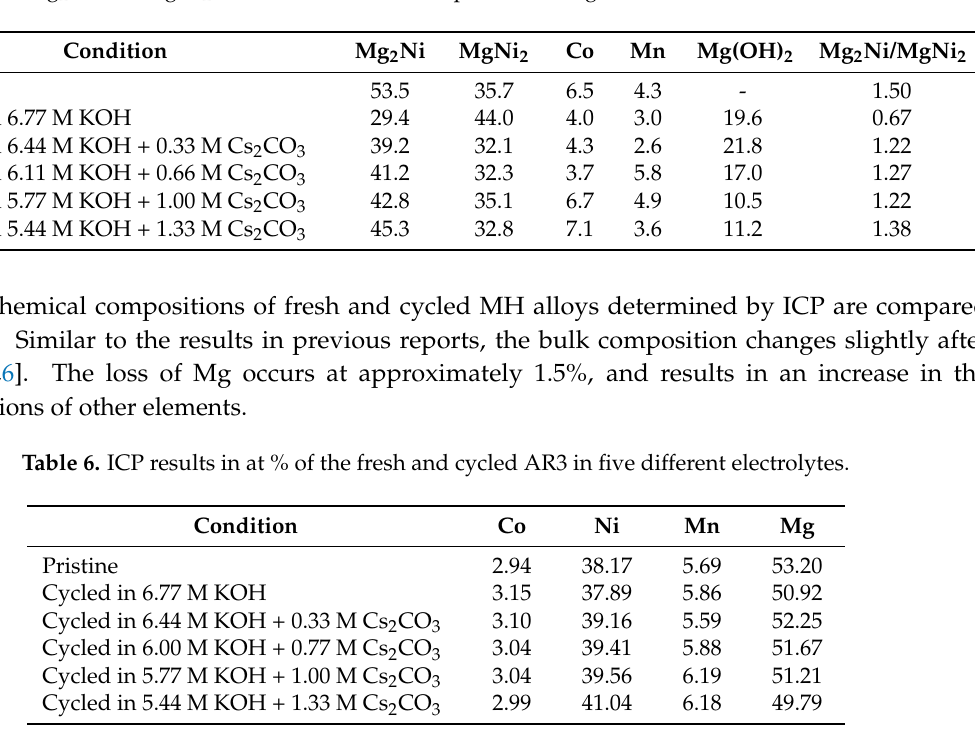
Table 5. Abundances in wt % of the Mg 2 Ni, MgNi 2 , Co, Mn, and Mg(OH) 2 phases, and the ratio between Mg 2 Ni and MgNi 2 obtained from the XRD patterns in Figure 5.